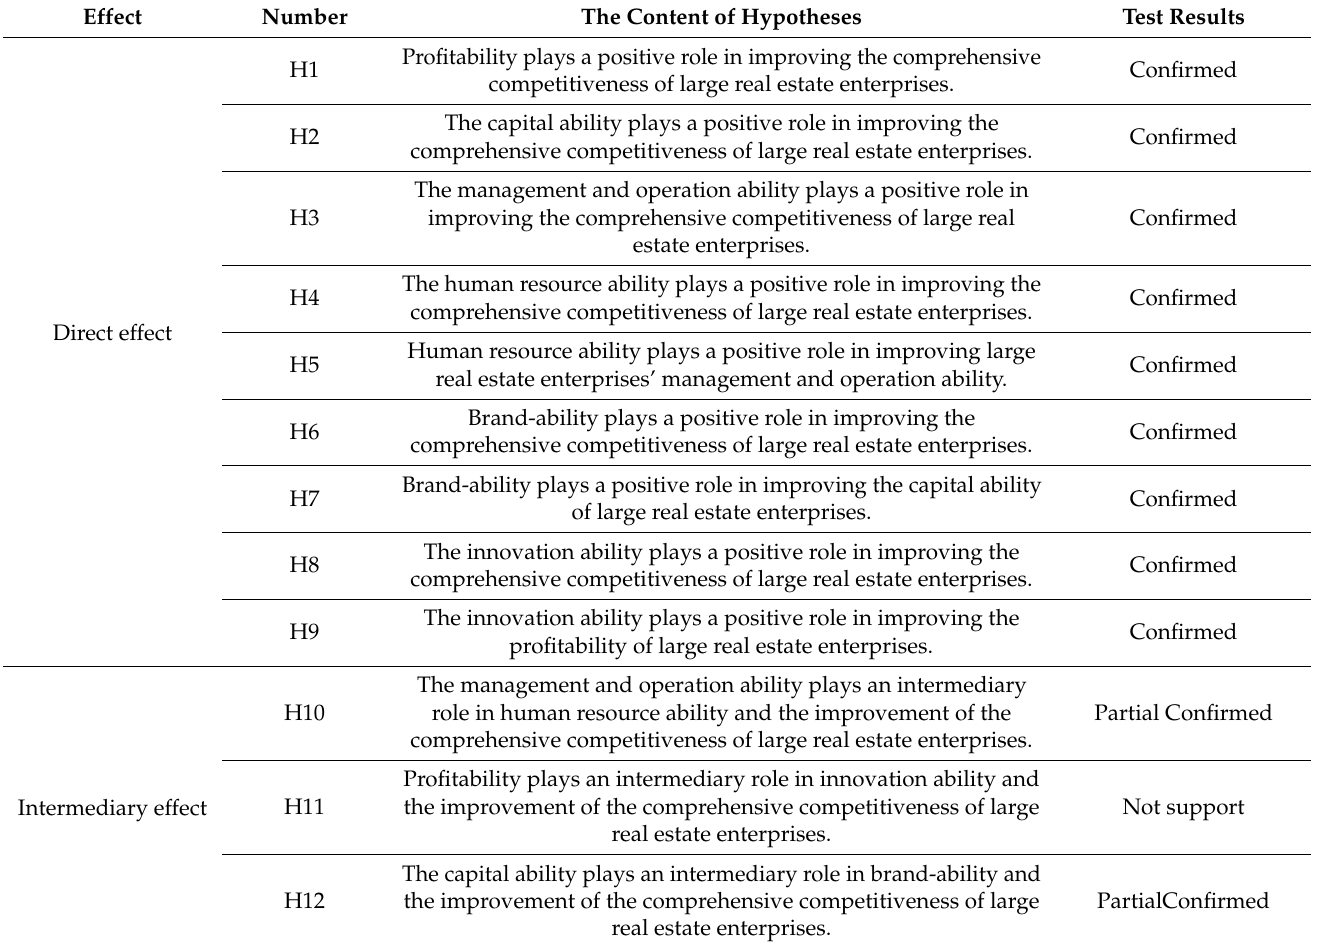
Table 9. The summary of hypothesis test